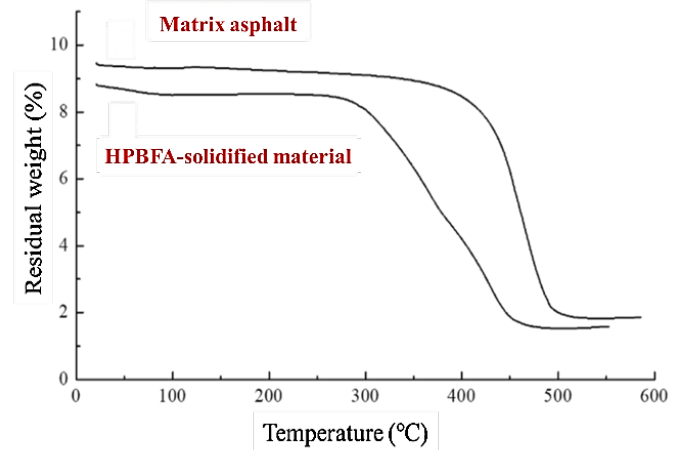
Figure 17. TG Figure 17. TG curve.